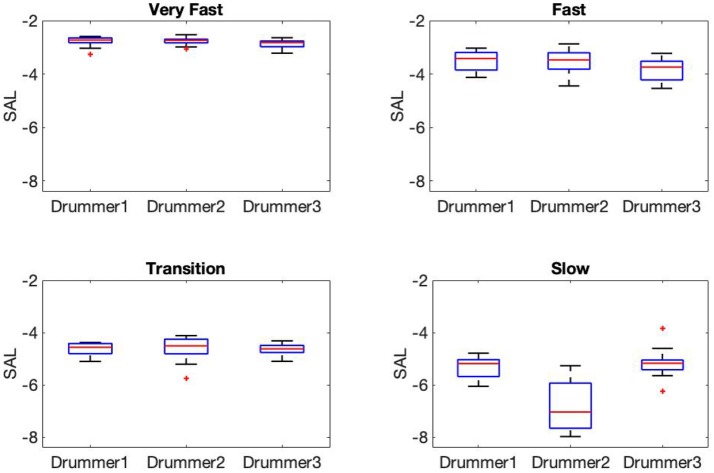
SAL metric for the three drummers computed across different phases: Very fast (top left panel), fast (top right panel), transition (bottom left panel), and slow (bottom right panel). Each box displays the range of upper and lower quartile values with the median as a red line in the middle. Whiskers are showing maximum and minimum values. As can be seen, SAL decreases with decreasing inter-onset intervals for all players but more so for D2. The lower SAL at slower tempi is explained by the sharper velodicty curve at impact for the more separated strokes (see Figure 4).